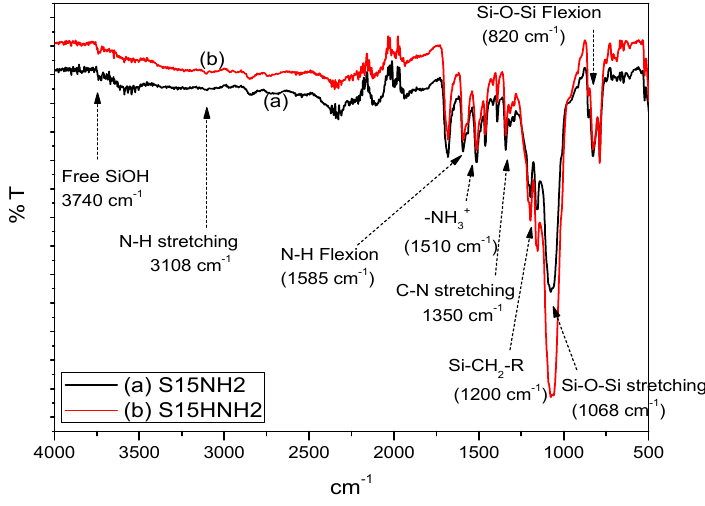
Figure 2. FTIR spectra of SBA-15 materials: ( a ) S15 precursor; and ( b ) S15H SBA-15 + NaOH 0.025 M samples, both characterized after functionalization with the same amount of 3-aminopropyltriethoxysilane (APTES).